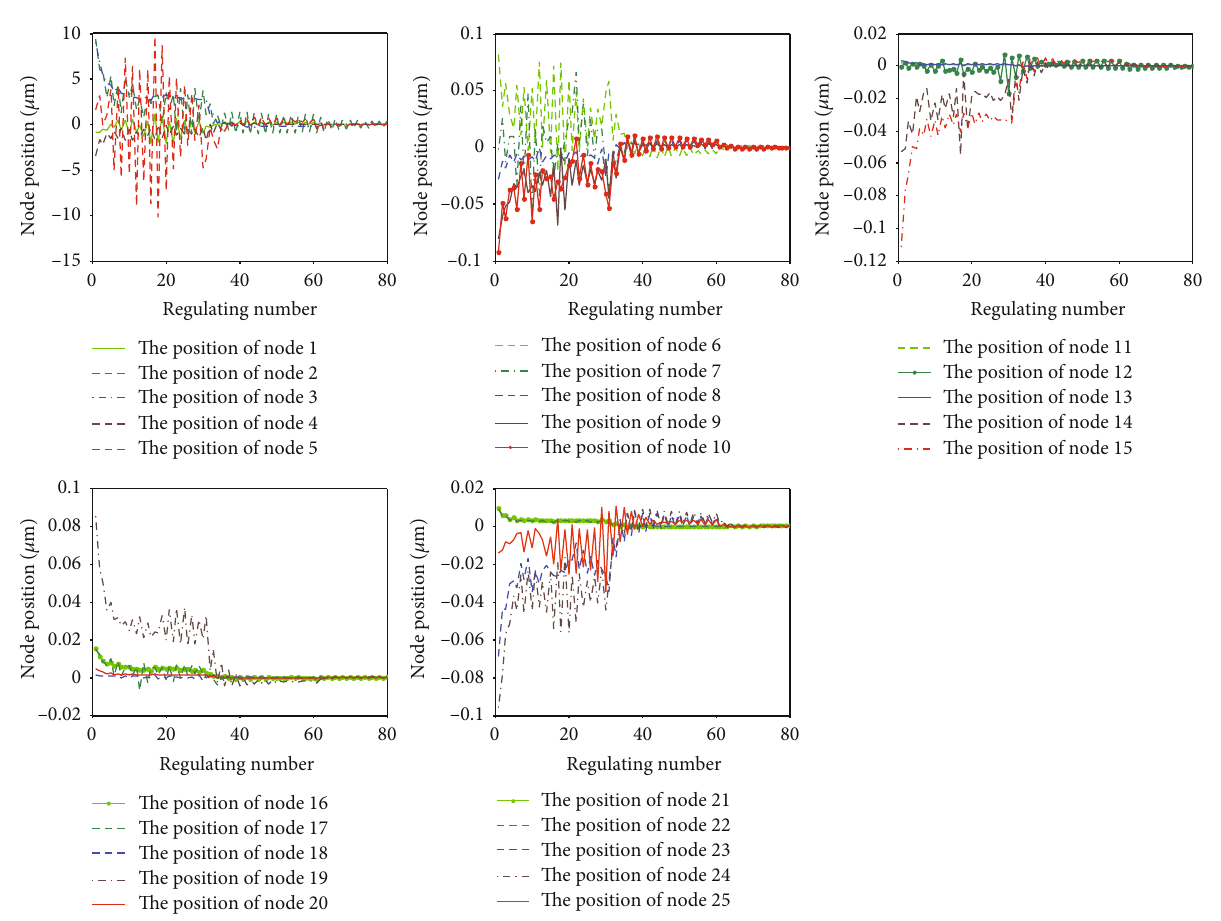
Figure 13: FNNQL adjustment curve with a disturbance of 30%.